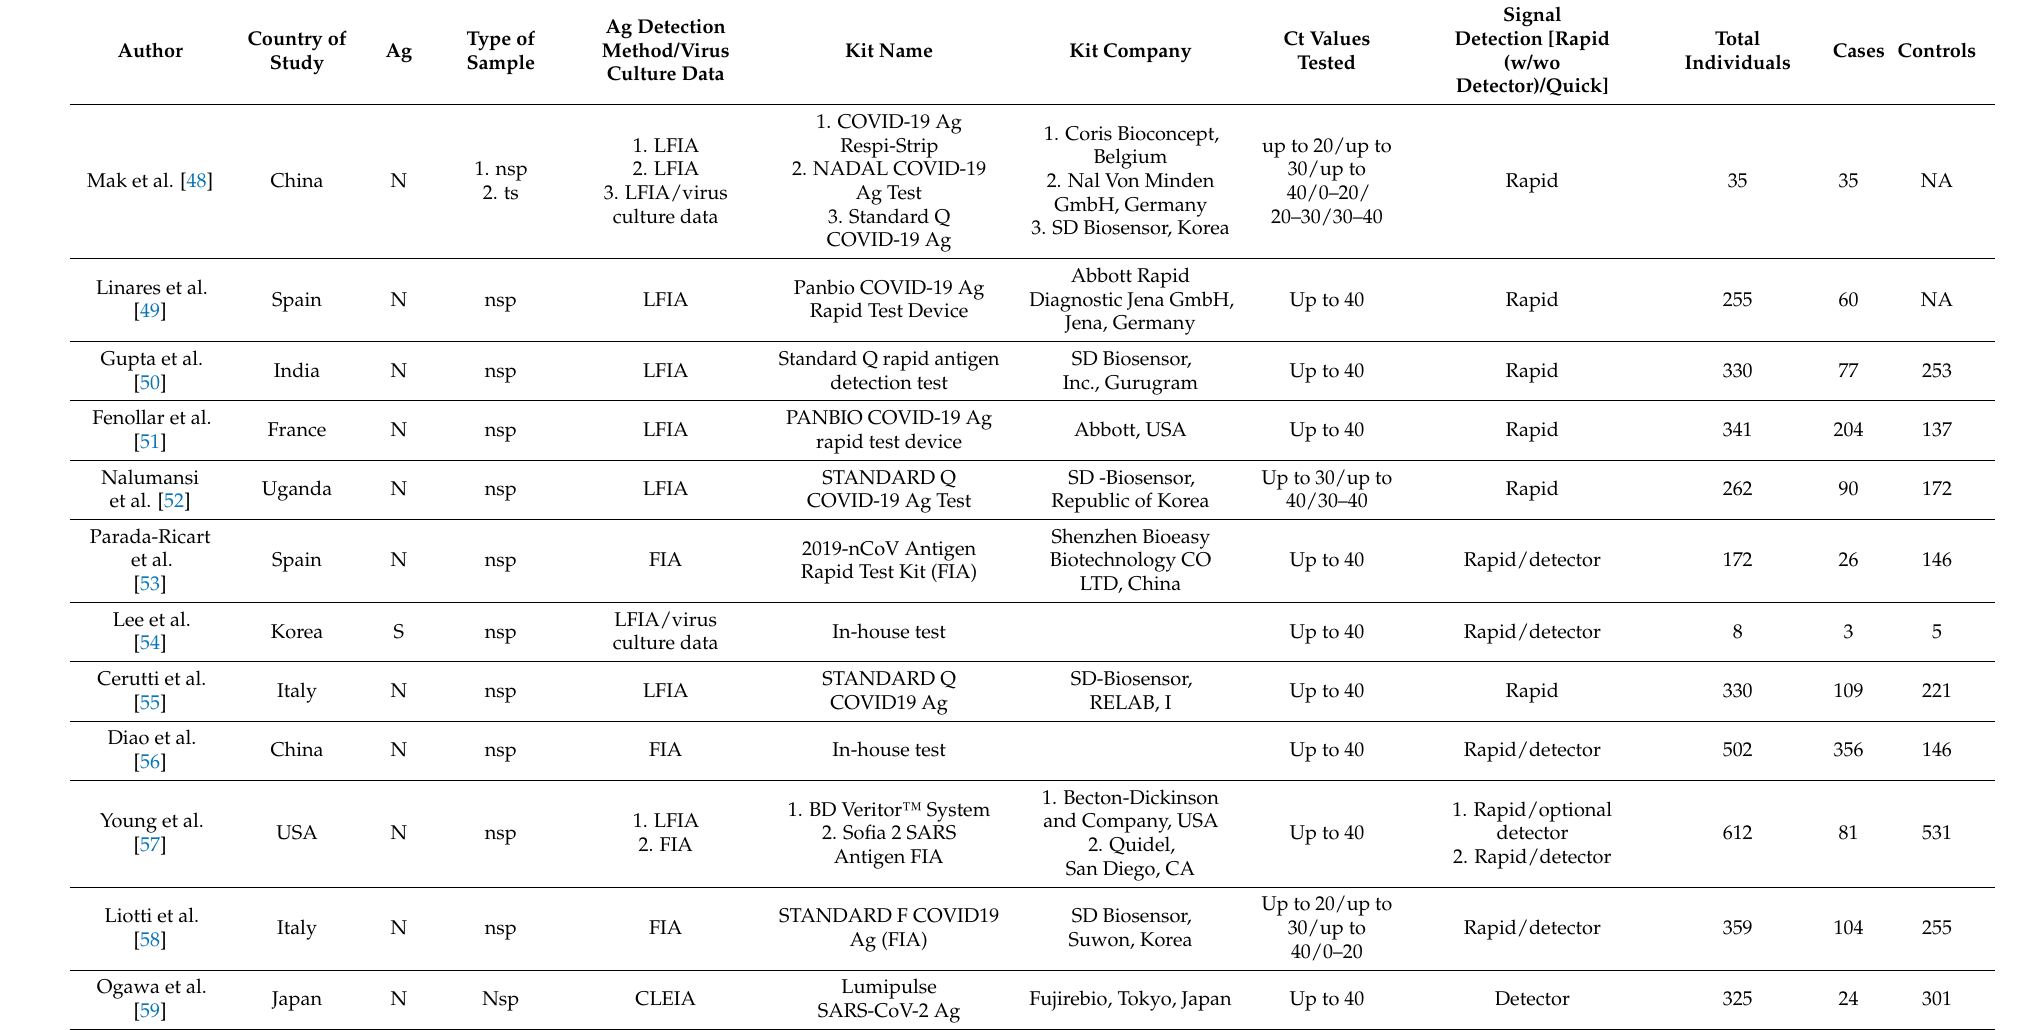
Table 1. Characteristics of the 235 studies included in the